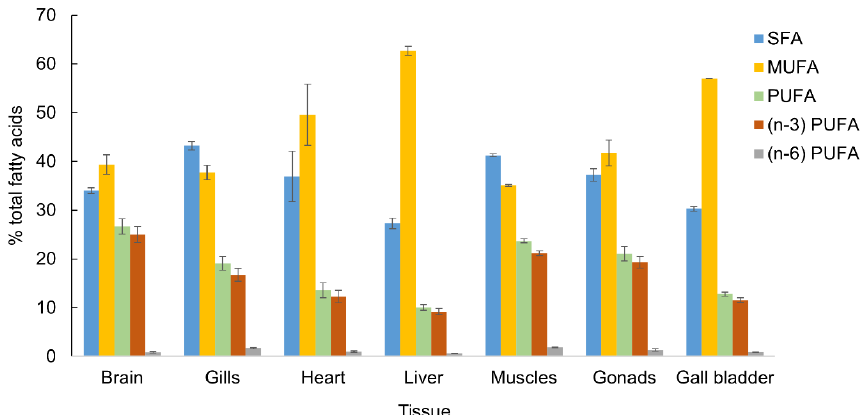
Figure 2. The content of fatty acid groups (% of total fatty acids) in different tissues of adult Antarctic silverfish Pleuragramma antarcticum from the Antarctic Sound, January 2022. Abbreviations: SFA — saturated fatty acids, MUFA — monounsaturated fatty acids, PUFA — polyunsaturated fatty acids, (n − 3) and (n − 6) — families of PUFA.